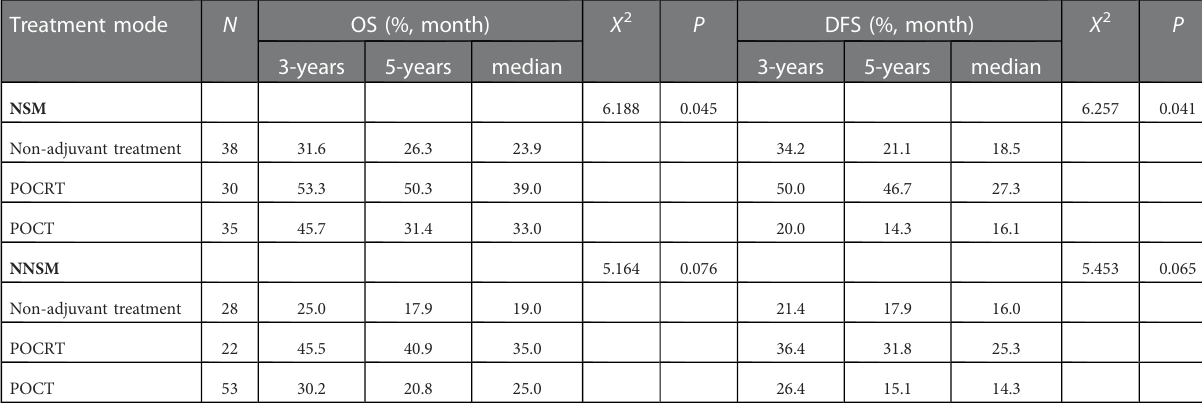
TABLE 7 Effect of different postoperative adjuvant treatment modes on the prognosis of patients with different sites of metastatic nodes after PSM. Treatment